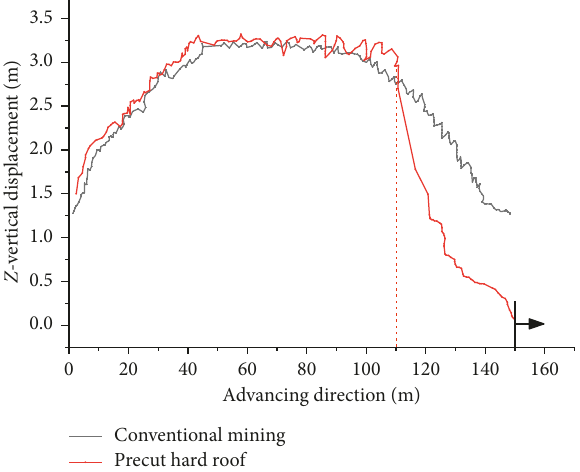
Figure 4: Vertical displacement in key strata above gob of